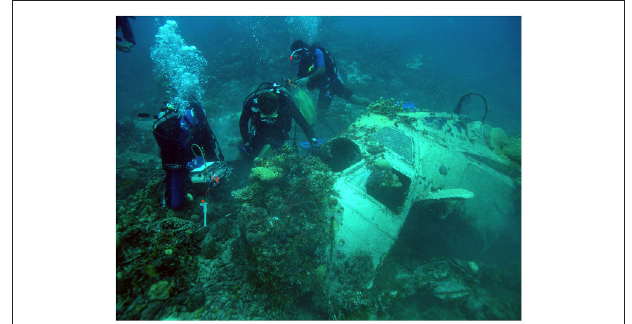
growth after 62 years of immersion in